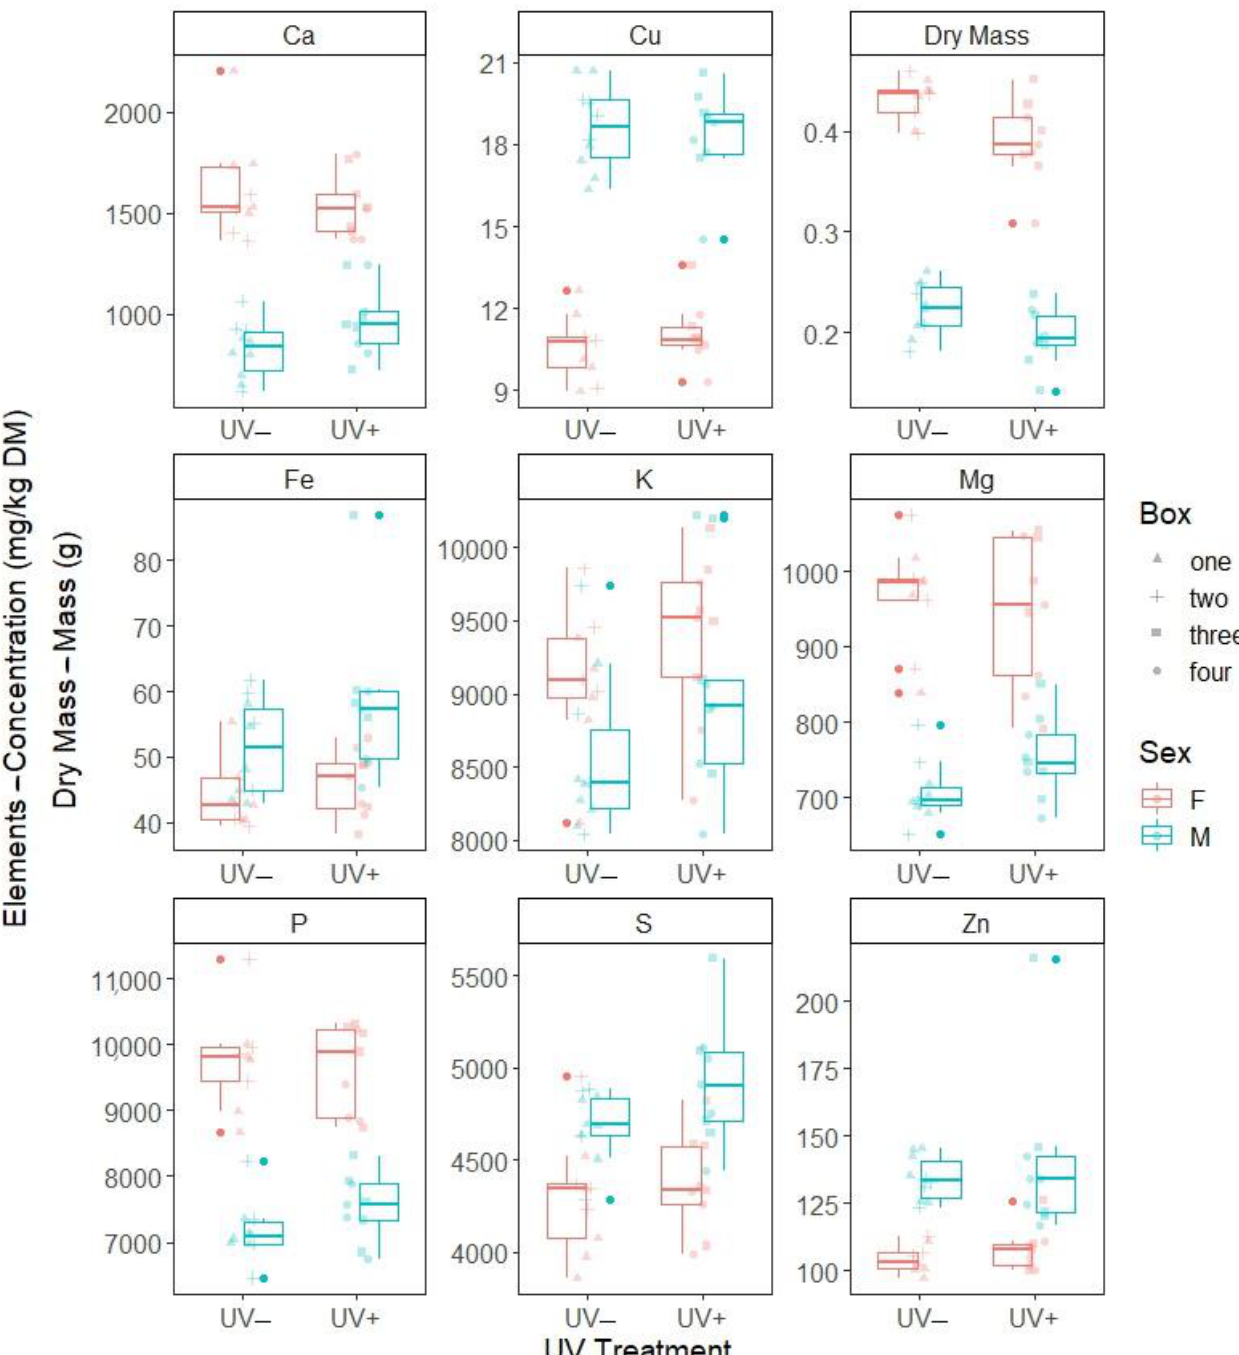
Figure 1. Mineral concentrations and dry mass of male and female crickets under UV+ and UV− treatments, split by box (treatment). Only response variables where significant effects of treatment and/or sex were detected are shown; see Table 2 for full statistical outcomes. Wet mass is not shown, as it presented identical patterns to dry mass.